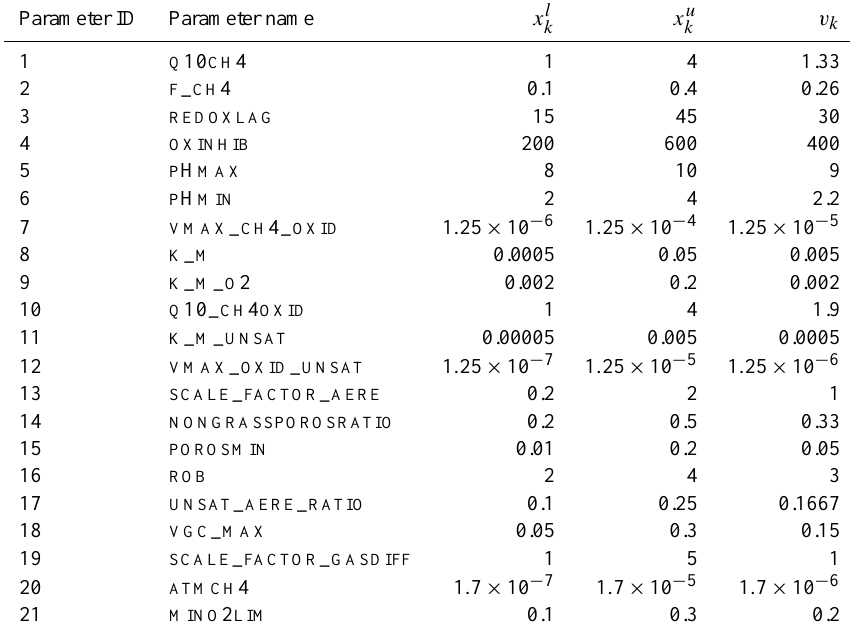
Table 1. CH 4 related parameters in CLM4.5bgc and their upper and lower bounds x u v k